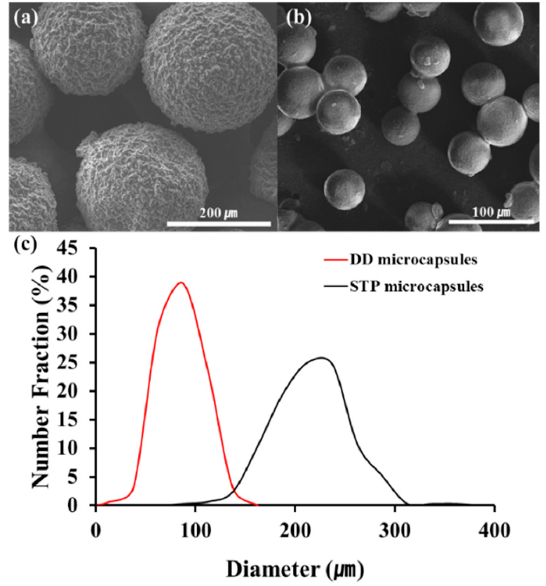
Figure 4. SEM images of ( a ) the STP-containing microcapsules and ( b ) the DD-containing microcapsules; ( c ) Size distribution of STP and DD microcapsules prepared at 1000 rpm.